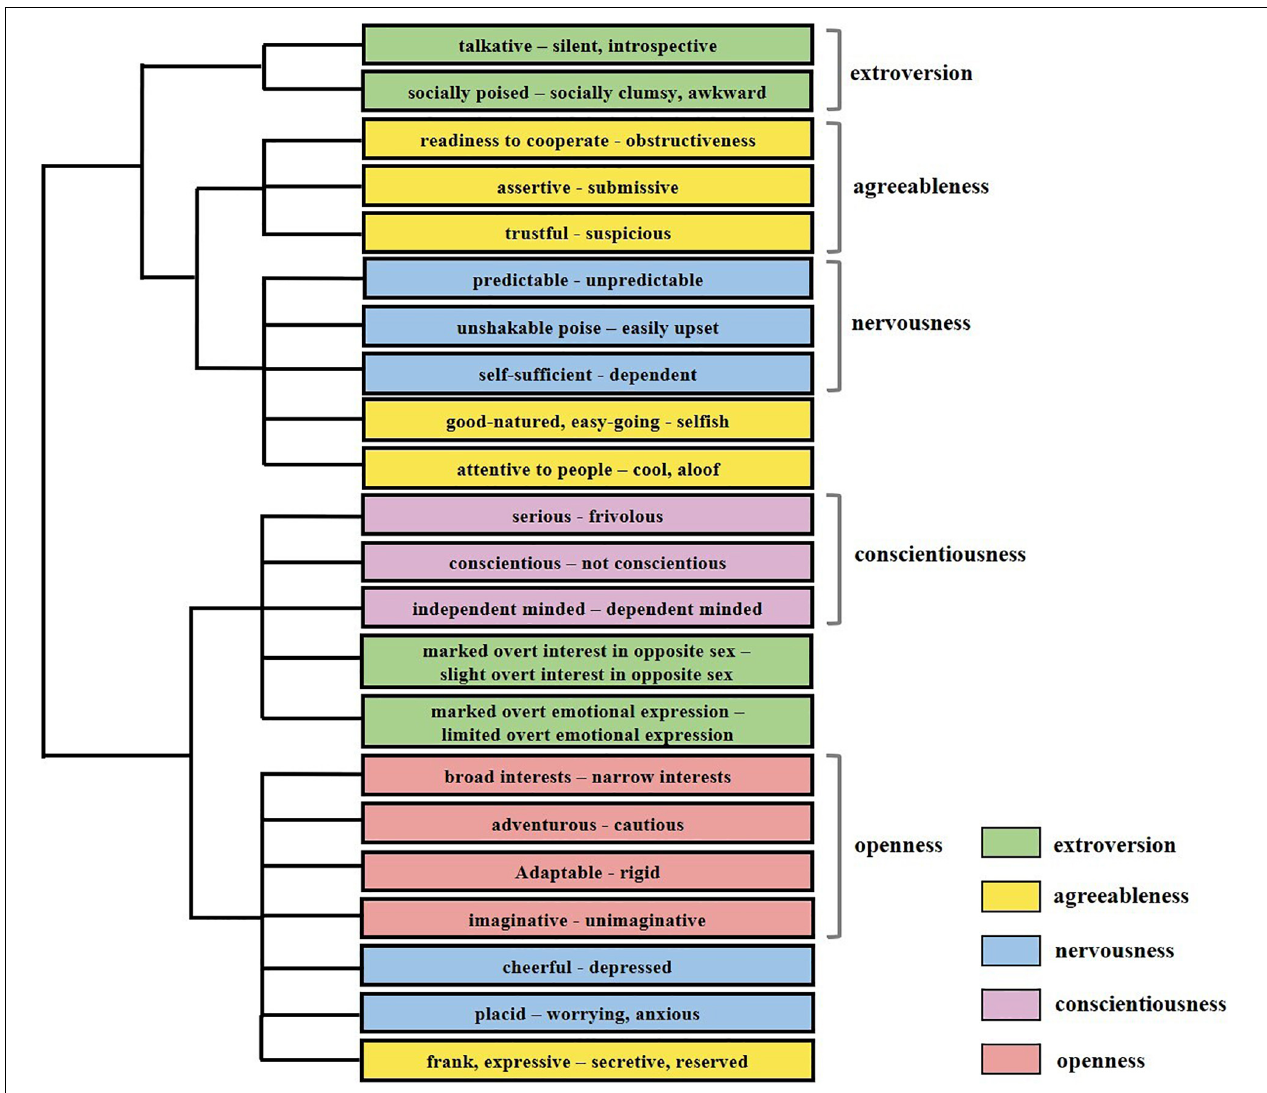
FIGURE 2 | Apart from fifteen word groups clustered into correct dimensions, seven word groups were clustered into incorrect dimensions compared with results we identified. The pairs attentive to people – cool, aloof; good-natured , easy-going – selfish , and frank , expressive – secretive, reserved were not clustered into agreeableness. Marked overt interest in opposite sex – slight overt interest in opposite sex; and marked overt emotional expression – limited overt emotional expression were not clustered into extroversion. Cheerful – depressed ; and placid – worrying, anxious were not clustered into neuroticism. Colors denotes word groups’ categories in the Big Five personality